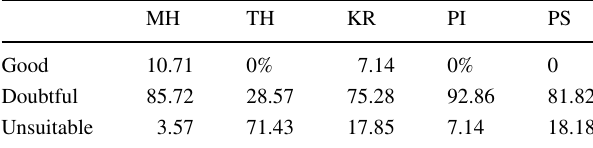
Table 3 Distribution of the calculated ionic